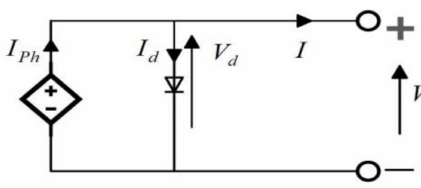
Figure 3. The idealised single-diode model (SDM) model of a PV